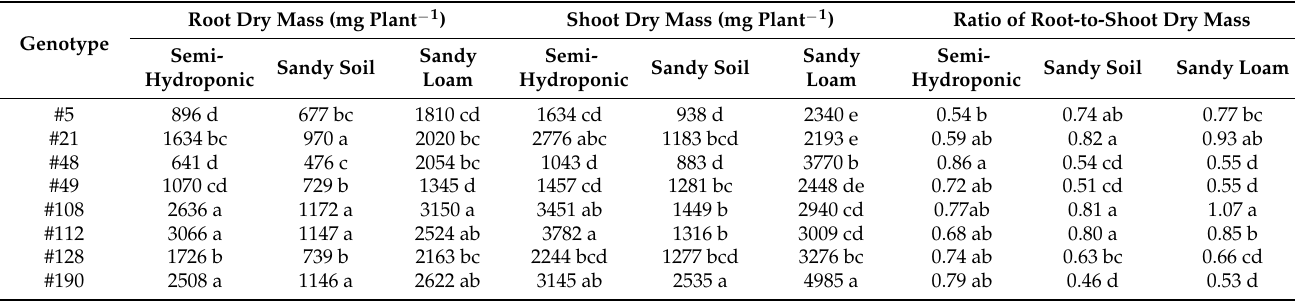
Table 6. Mean values of total root length, average root diameter and shoot height of eight selected barley genotypes grown in the semi-hydroponic system and two soils in a temperature-controlled glasshouse.